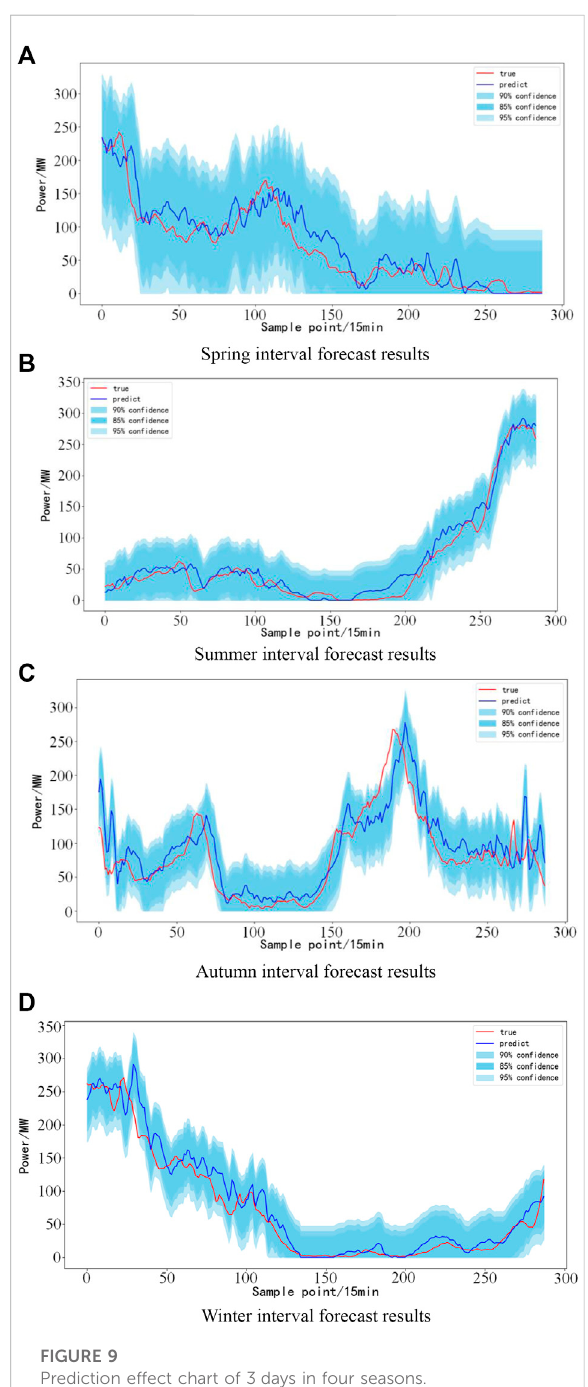
FIGURE 9 Prediction effect chart of 3 days in four